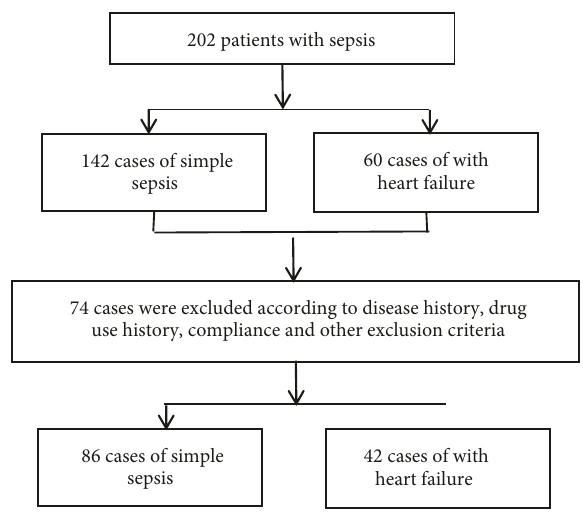
Figure 1: Case exclusion flow